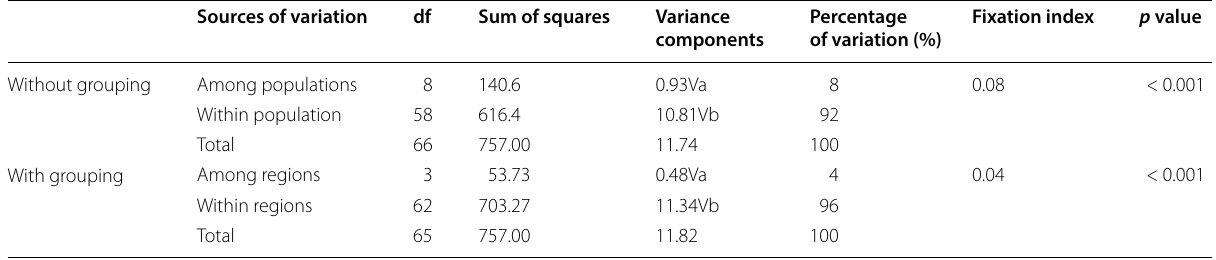
df degrees of freedom